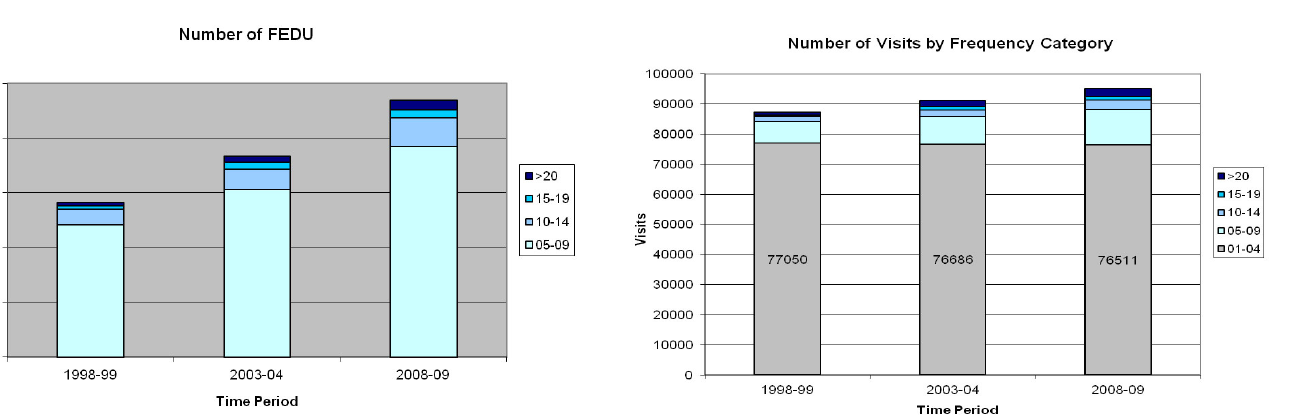
Figure 2. Number of emergency department visits by each frequent emergency department users group in years 0,5, &